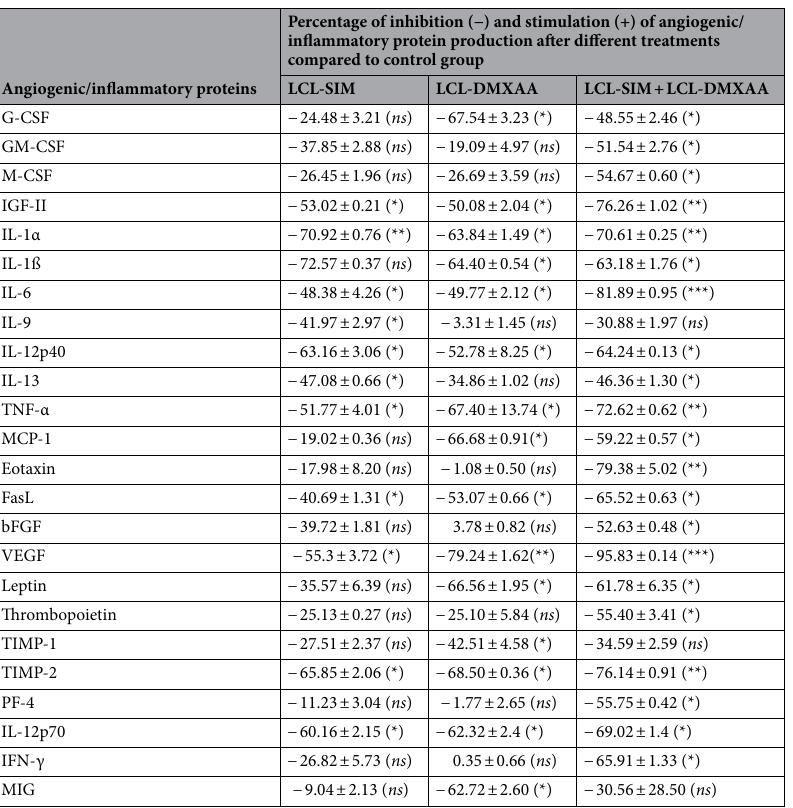
Table 3. The effects of LCL-SIM and LCL-DMXAA administered as single as well as combined treatment on TME angiogenic/inflammatory protein production. The angiogenic/inflammatory protein levels in tumor lysates after different treatments are compared to control– LCL-treated group levels of the same proteins. The results are expressed as % of the average inhibition (−) or stimulation (+) ± SD of two independent measurements. The two-way ANOVA Multiple Comparison Test was used to compare overall effects on the production of pro- /antitumor proteins in tumor lysates from all experimental groups ; LCL-SIM— experimental group treated with 5 mg/kg SIM as liposome-encapsulated form; LCL-DMXAA—experimental group treated with 14 mg/kg DMXAA as liposome-encapsulated form; LCL-SIM + LCL-DMXAA— experimental group treated with 5 mg/kg SIM and 14 mg/kg DMXAA as liposome-encapsulated forms ( ns , P > 0.05; *, P < 0.05; **, P < 0.01; ***, P <